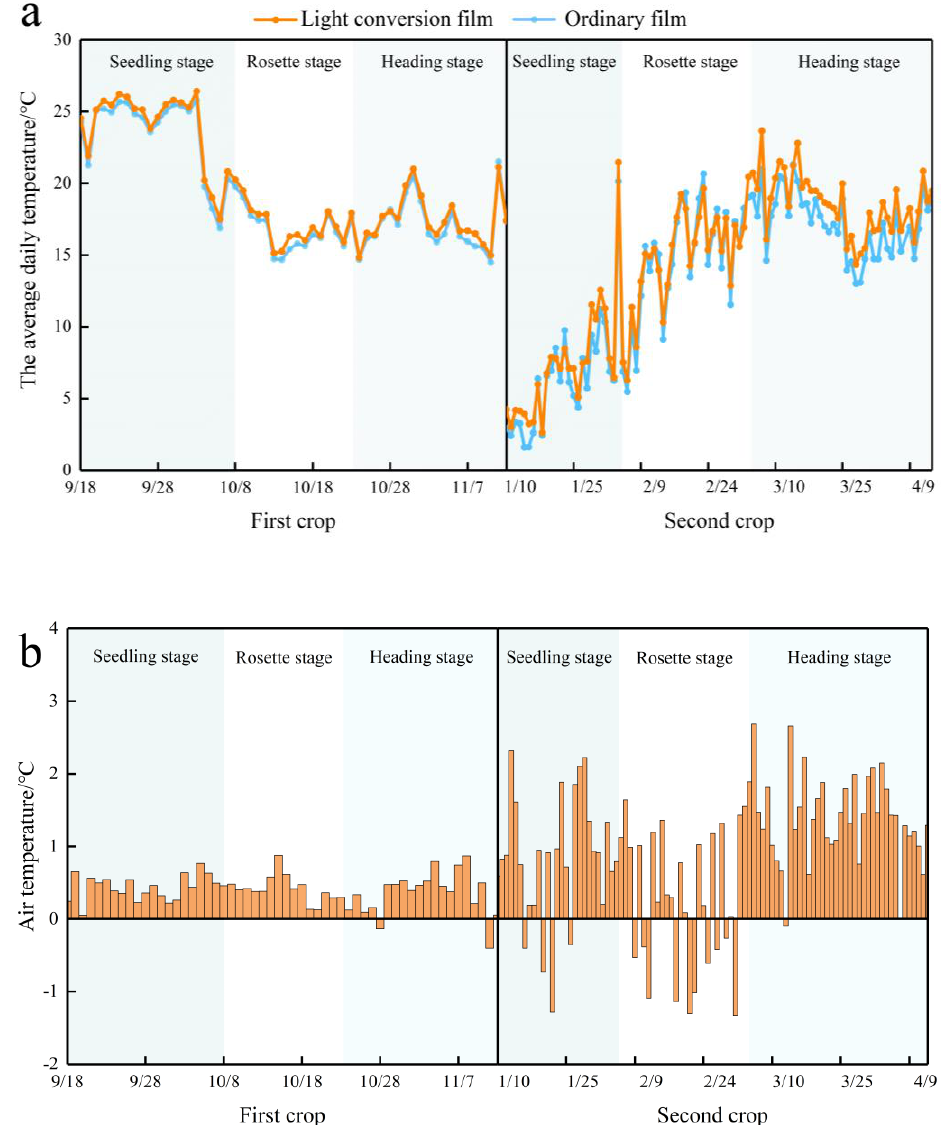
Figure 4. Effects of light conversion film (LCF) and ordinary film (OF) on greenhouse air temperature under different crops. ( a ) Indicates the daily average air temperature change in the greenhouse environment under the light conversion film and ordinary film. ( b ) Variable representing the difference between daily average air temperature of light conversion films and ordinary films.